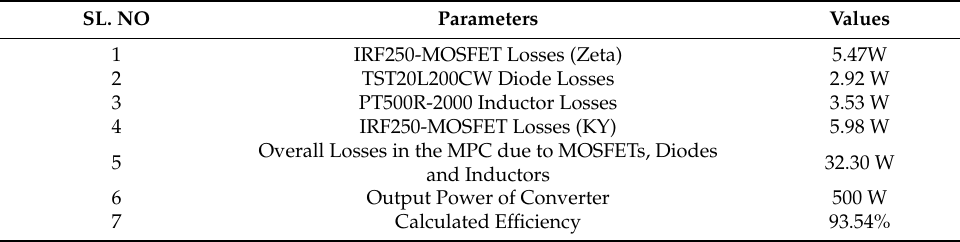
Table 4. Calculation of efficiency of the converter through different losses.